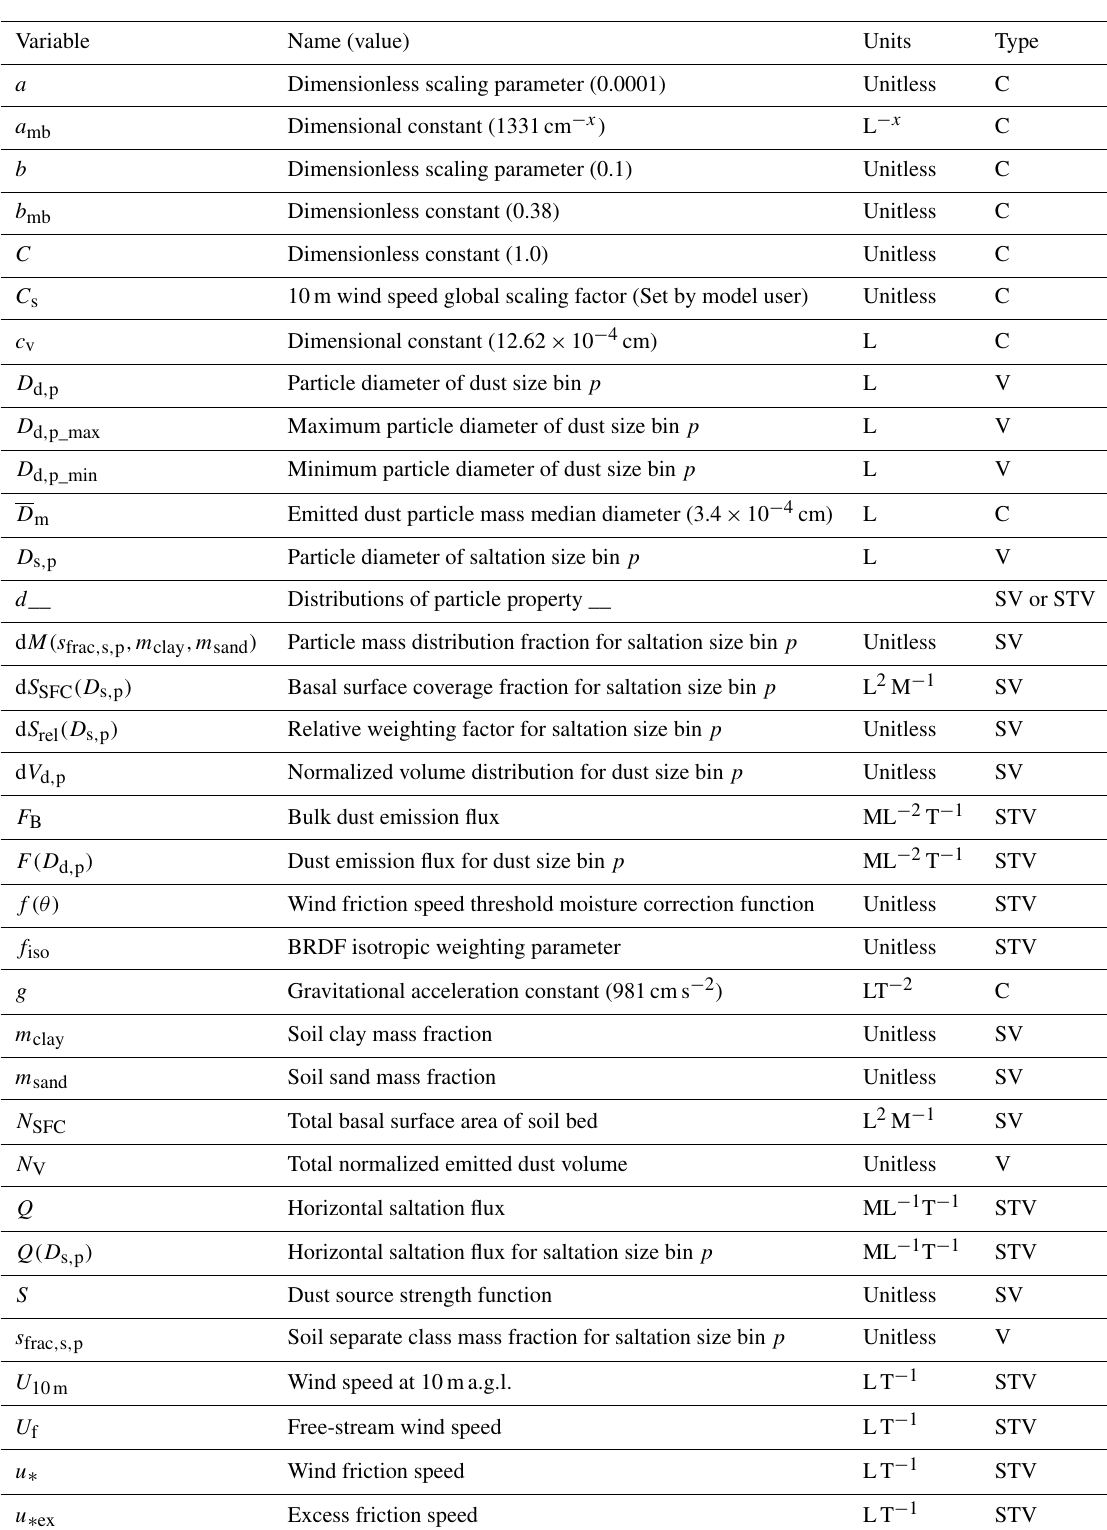
Table A1. Variable list. Units are provided in terms of mass [M], length [L], and time [T]. In the Type column, “C” implies the parameter is a prescribed constant or global scaling factor, “V” indicates the parameter is a prescribed one-dimensional array of size-bin-related settings, “SV” parameters are spatially varying static fields, and “STV” parameters are spatiotemporally varying dynamic